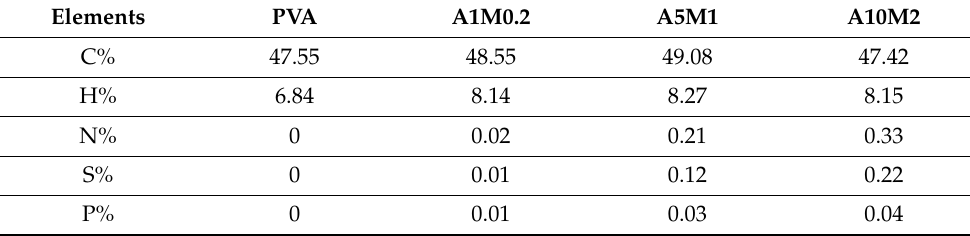
Figure 1. Construction and characterization of the HPX/PVA hydrogels. ( A ) Schematic illustrations of the preparation of the HPX/PVA hydrogels. UV-vis absorption spectra of extracts of the HA/PVA hydrogel ( B ); HA/PA/PVA hydrogel ( C ); HA/PM/PVA hydrogel ( D ). ( E ) The FTIR spectra of the PVA and HPX/PVA hydrogels. ( F ) The XRD patterns of the PVA and HPX/PVA hydrogels. ( G ) The DSC curves of the PVA and HPX/PVA hydrogels. Table 1. The element contents of the PVA and HPX/PVA